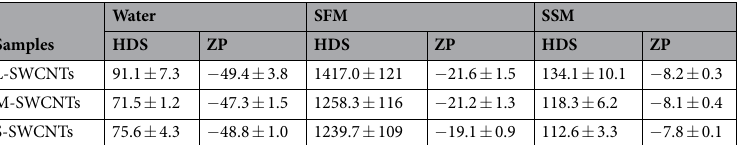
blue staining of the gel, which showed the separation of cellular proteins from SWCNTs and the deposition of SWCNTs within gel as a band, no SWCNTs were detected in other areas of the gel (Supplementary Fig. 2). The standard curve (R 2 = 0.992) for protein amount against cell number was acquired by bicinchoninic acid (BCA) assay and the standard curve (R 2 = 0.987) for the amount of SWCNTs against the band intensity was deter- mined by SDS-PAGE gel analysis, both standard curves showed good linear relationships (Supplementary Fig. 3). Therefore, with known loading amount of protein and SWCNT band intensity, we can calculate the average mass